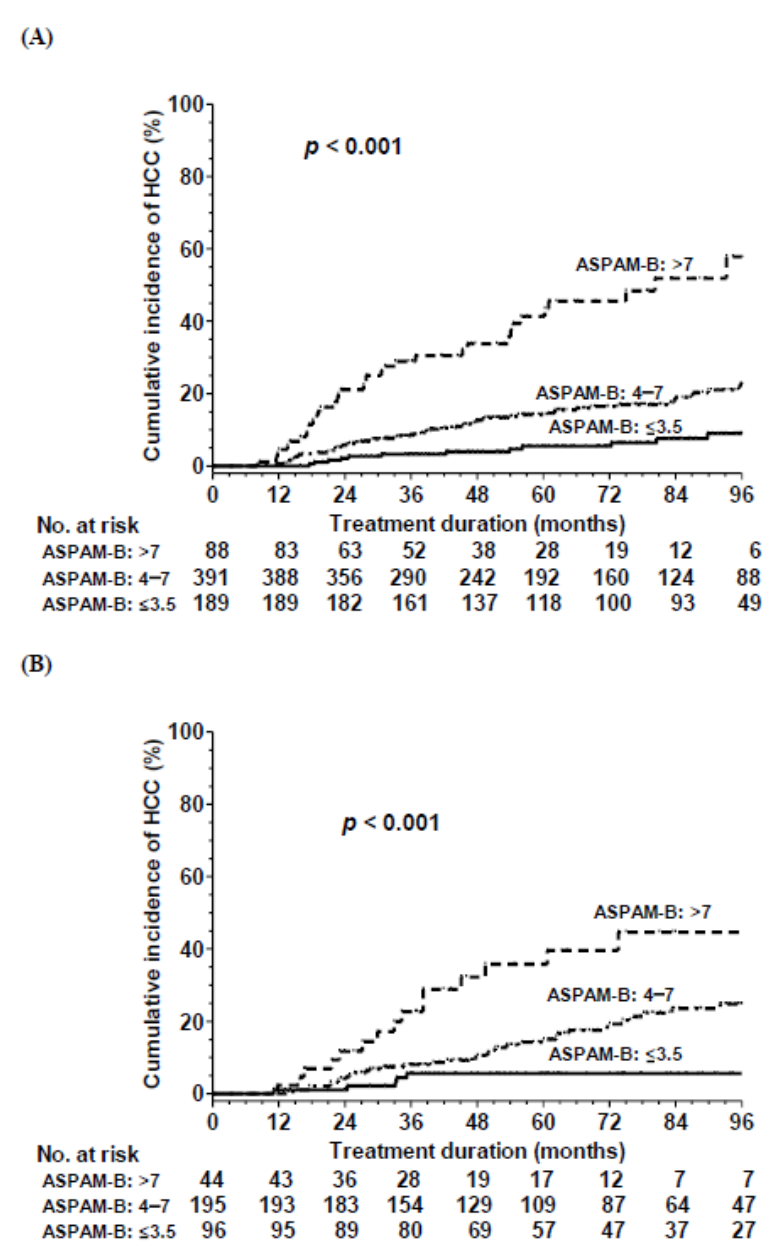
Figure 3. Cumulative incidence rate of HCC according to the ASPAM-B risk score in the ( A ) development and ( B ) validation cohorts.